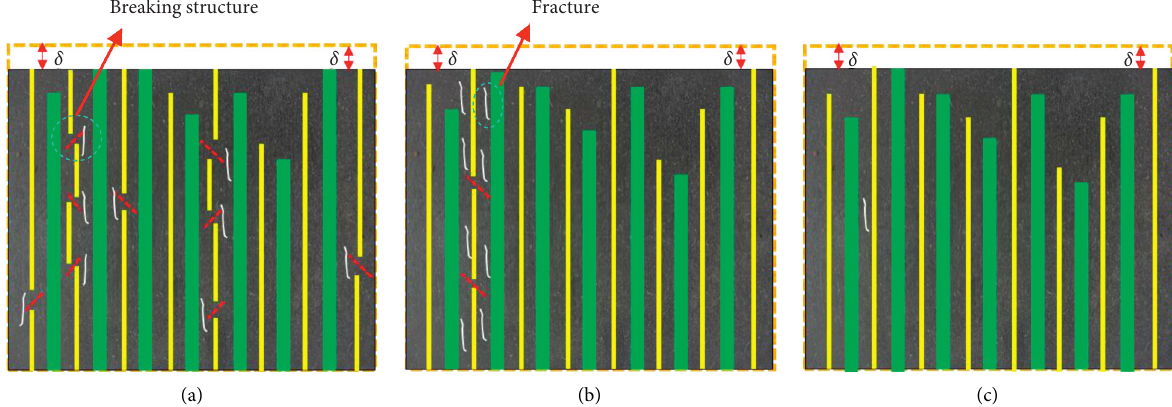
Figure 11: Failure structure of samples under different loading rates: (a) the loading rate is 5 × 10 − 7 m/s; (b) the loading rate is 5 × 10 − 5 m/s; (c) other loading